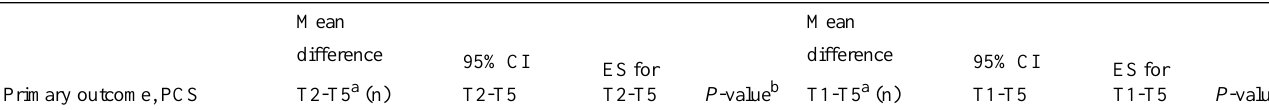
Table 3. Within-group differences and effect sizes (ES) for the primary